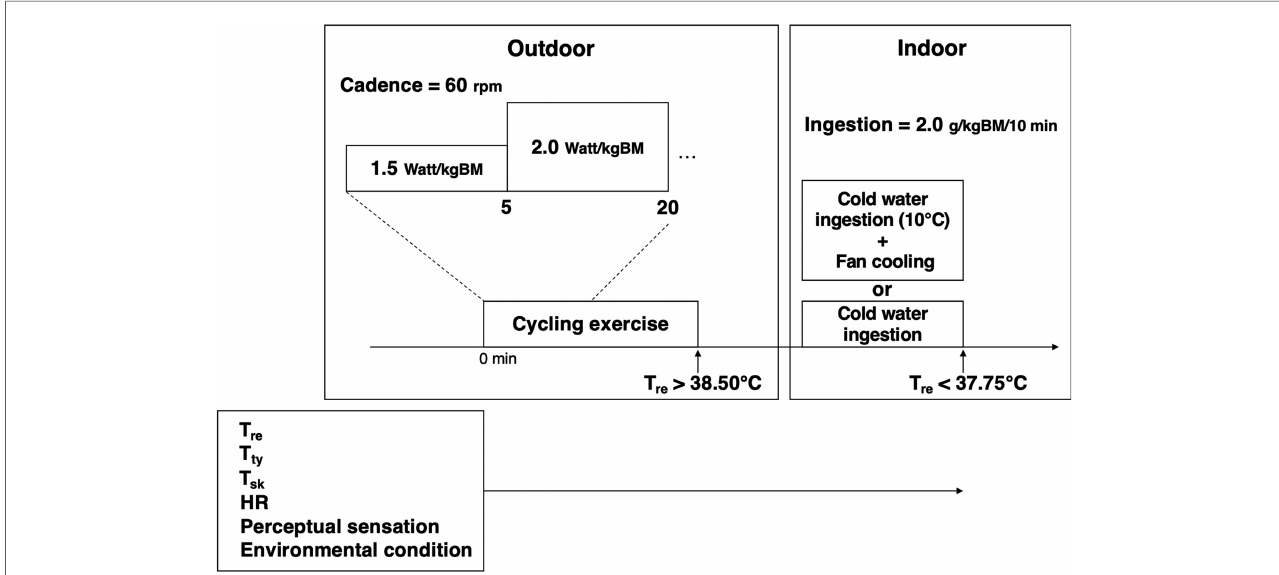
FIGURE 1 Schematic representation of the experimental protocol. BM, body mass; HR, heart rate; Tty, tympanic temperature; Tre, rectal temperature; Tsk, mean skin temperature.